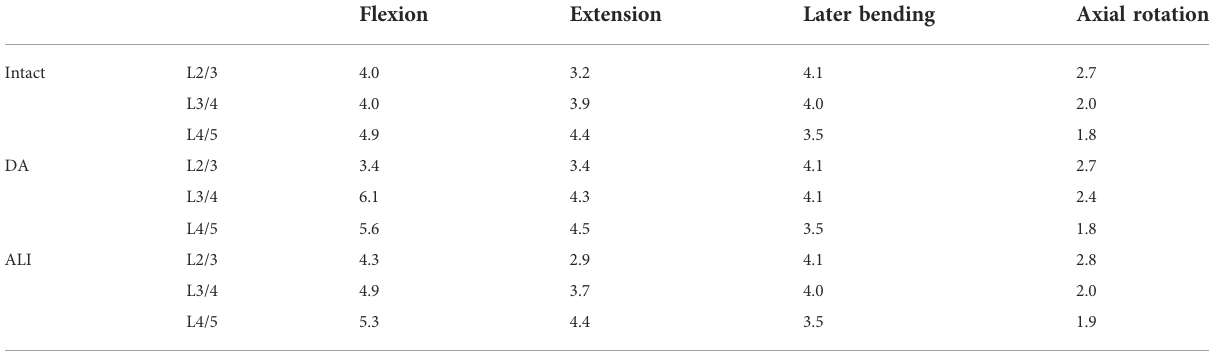
TABLE 2 ROM of the surgical segment and adjacent segment ( °